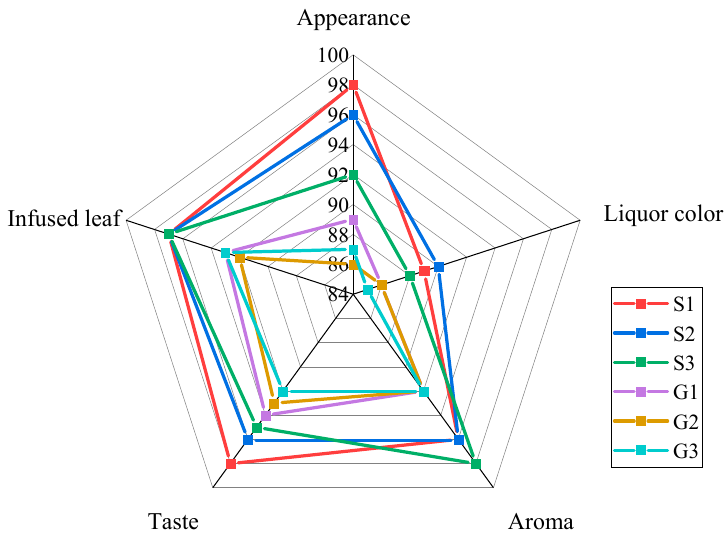
Figure 2. Sensory evaluation scores of each grade.